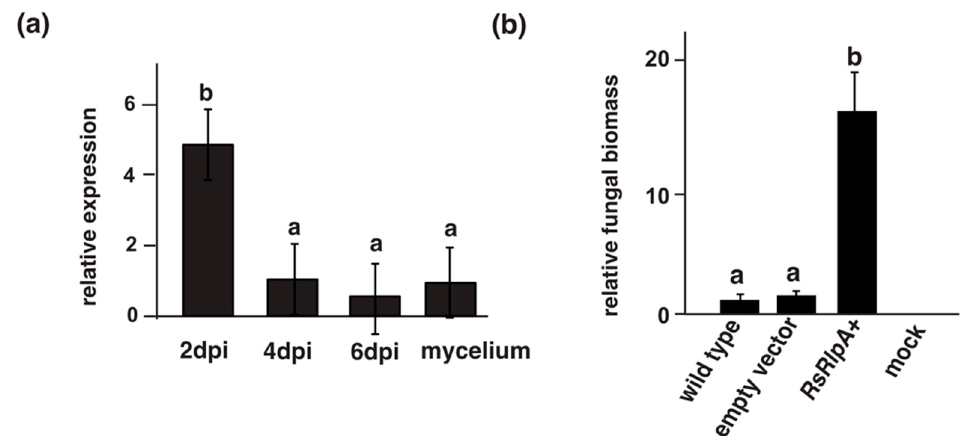
Figure 1. Analysis of the RsRlpA candidate effector. ( a ) Transcription patterns of the RsRplA gene upon sugar beet infection. Rhizoctonia solani mycelia was grown in potato dextrose broth (PDB) medium and used as control for comparison. The G3PDH gene was used as internal standard. Error bars represent SD based on at least three biological replicates. Different letters ( a , b ) indicate statistically significant differences according to Tukey’s test ( p value < 0.05). ( b ) Fungal biomass quantification upon infection of sugar beet leaves with Cercospora beticola wild type, empty vector and RsRlpA+ overexpression strains, while inoculation with H 2 0 (mock) was used a negative control. For qPCR, the C. beticola actin ( act ) gene was used. Data were normalized with the elongation factor gene ( elf-1 ) from Beta vulgaris . Data show the average of three independent overexpression strains and three biological replicates. Different letters ( a , b ) indicate significant differences according to Tukey’s test ( p < 0.05) and error bars represent SD.